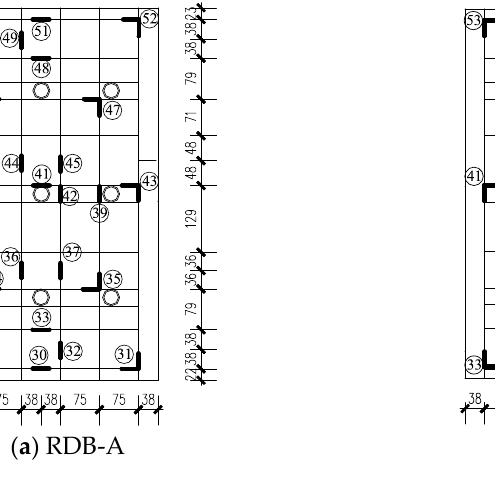
( b ) RDB-B Figure 4. Loading patterns for the test specimens. 3. Test Results 3.1. Failure Mode and Hysteretic Behavior The RDB-A failed to combine with the bend and shear destroy. An inclined crack was found at the bottom of the deep beam at the 2 mm loading step. At this loading step, concrete spalling was observed at the top side corner of the deep beam, but the reinforcing bars were not exposed, as shown in Figure 5a. New cracks were observed at the corner and bottom of the specimen at the story displacement of 3 mm, and a major crack had obviously developed along the direction of 45° in a horizontal direction. When the dis- placement reached 5 mm, the concrete at the bottom corners was apparently crushed, as presented in Figure 5b, which resulted in exposing the stirrups. A crisp noise was pro- duced from the high-strength bolts at this step. After that, a relative slip deformation was found, and the cracks developed quickly. The final failure pattern of the RDB-A specimen is depicted in Figure 5c. 0